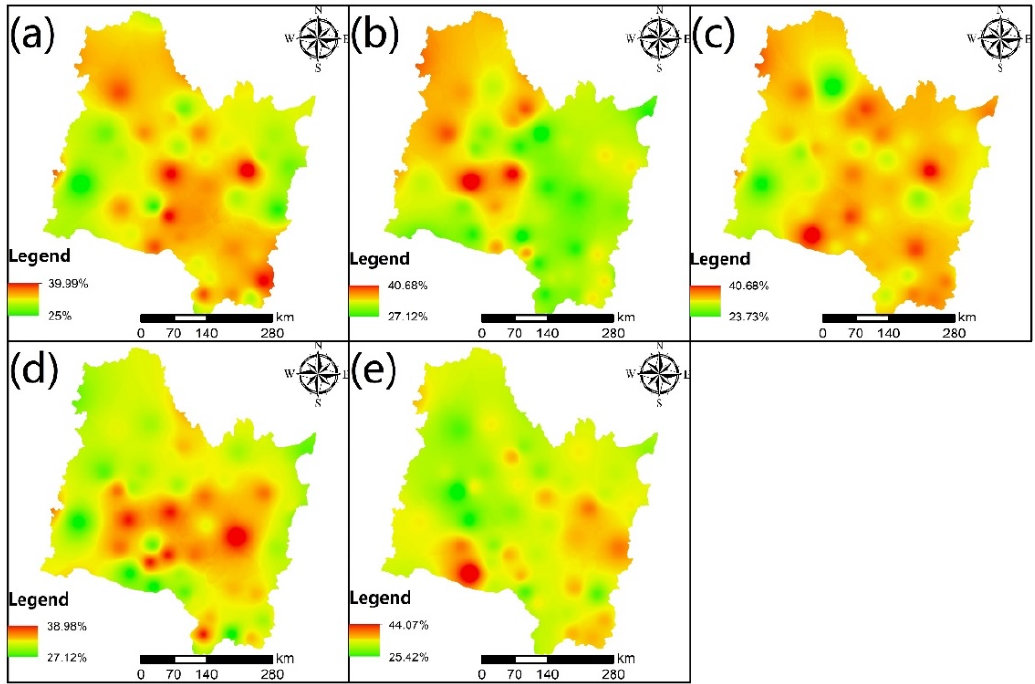
Figure 7. Spatial distribution of the drought probability on different scales within the SHRB from 1960 to 2019. ( a – e ) show the drought probability on an annual, spring, summer, autumn, and winter scale, respectively.